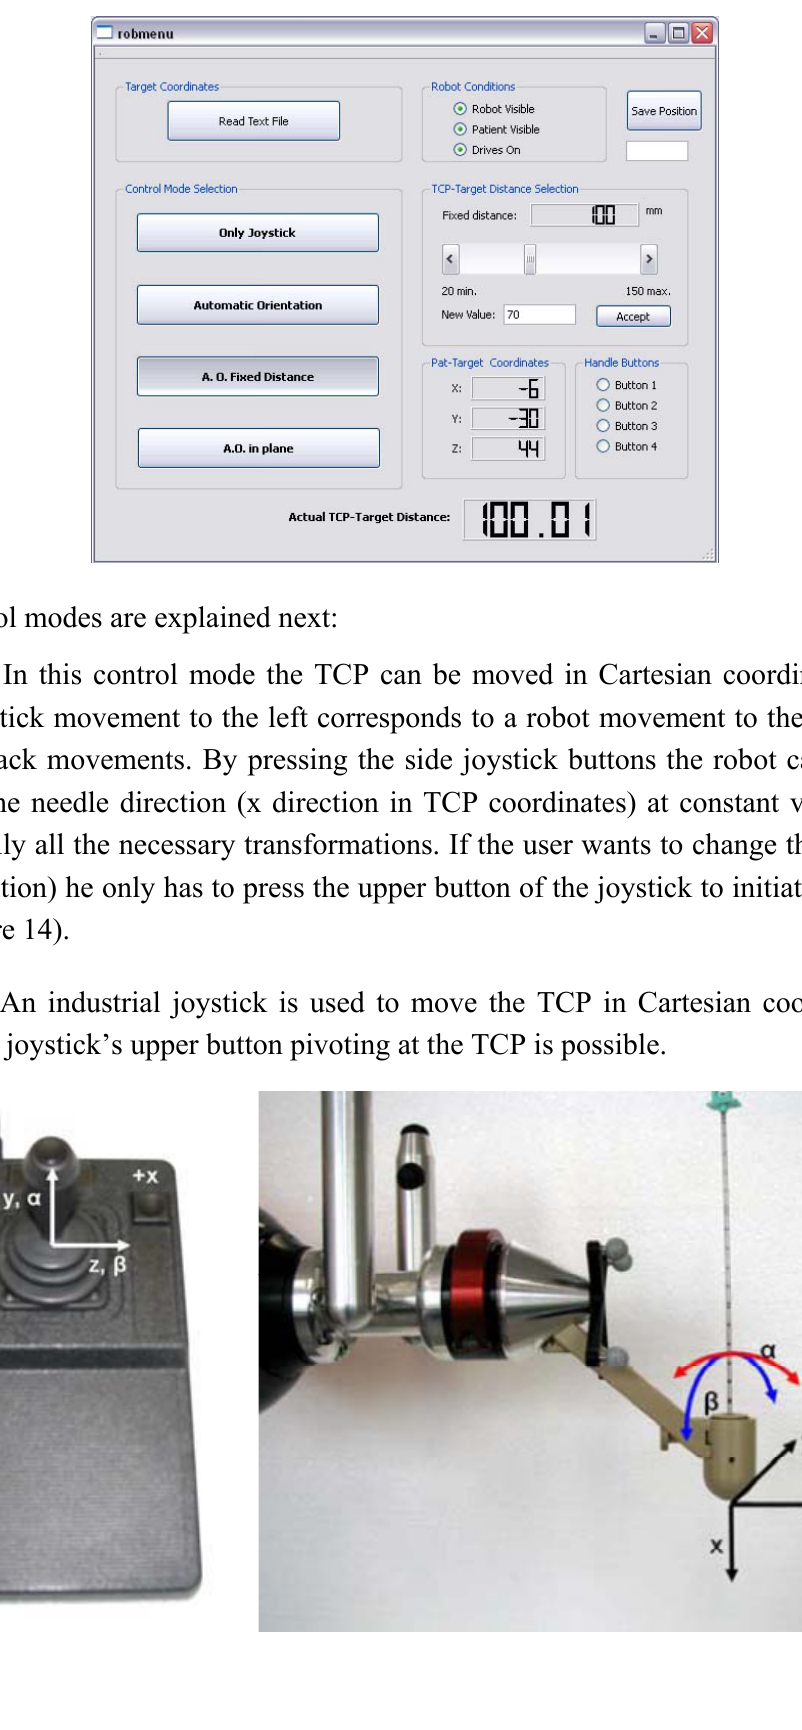
Figure 13. Graphical user interface. The user may select the desired control mode and trajectory coordinates. Also, the interface shows whether there is visual contact between the robot and the patient´s camera.